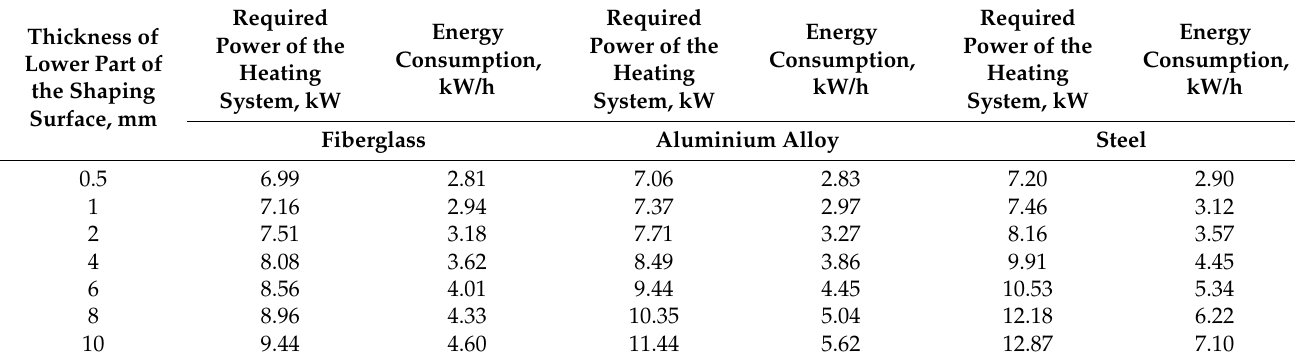
Table 2. Required power and energy consumption values for the heating system of moulding tool when the thickness of lower part of the shaping surface is changed.